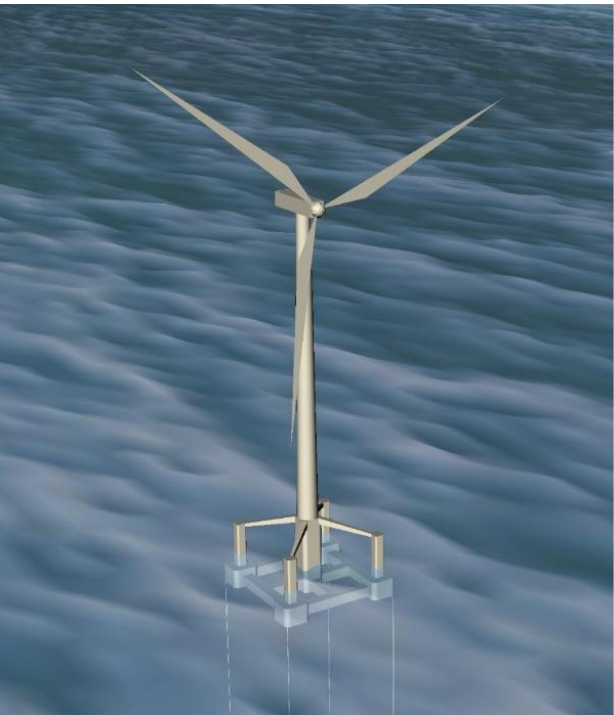
Figure 4. TLP concept developed by the Centre of Marine Technology and Ocean Engineering (CENTEC).